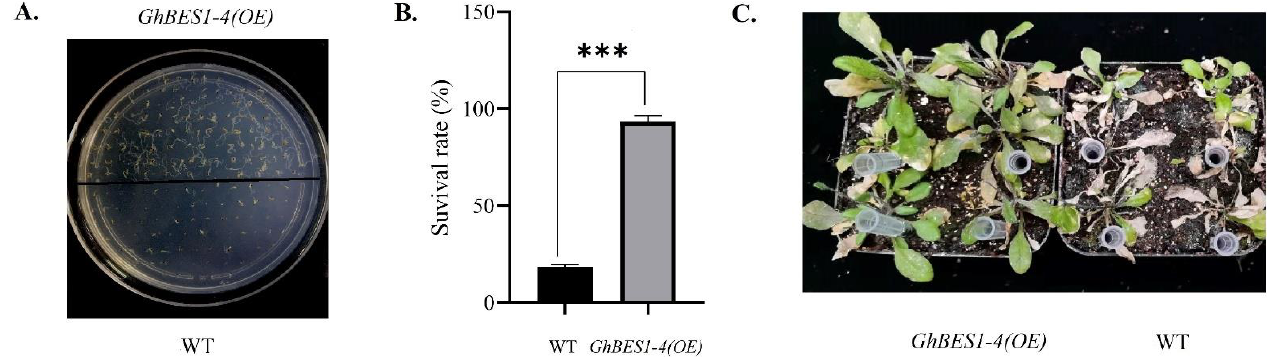
Figure 6. Functional verification of GhBES1-4 gene under salt stress. ( A ) Growth of GhBES1-4(OE) (the upper part) and WT (the lower half) seeds on 175 mM NaCl plates. ( B ) The survival rate of WT and GhBES1-4(OE) under 175 mM NaCl. ‘***’ indicates p < 0.005. ( C ) WT and GhBES1-4(OE) under salt stress .